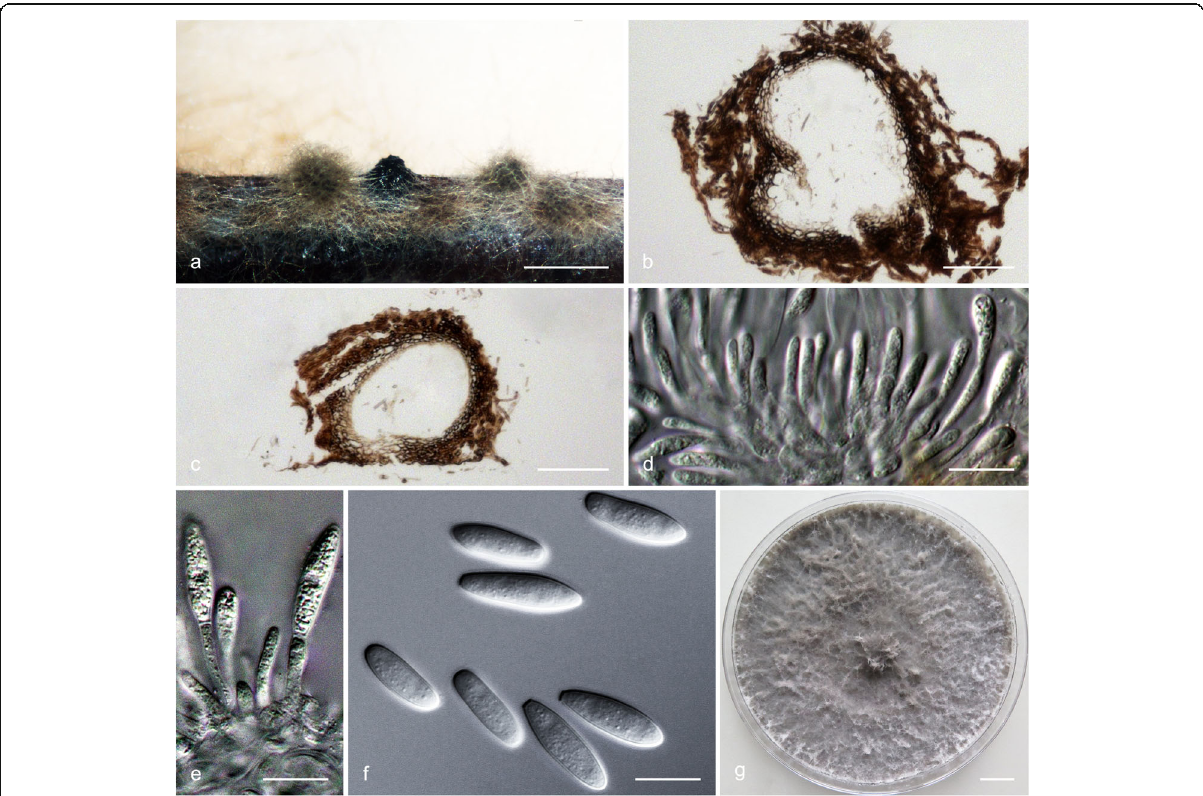
Fig. 10 Neofusicoccum yunnanense. a . Conidiomata formed on pine needle culture; b , c . Longitudinal section through conidioma; d , e . Conidiogenous cells and developing conidia; f . Conidia; g . Living culture after 10 d on 2% MEA (front). Scale bars: a=500 μ m; b, c=100 μ m; d – f=10 μ m;